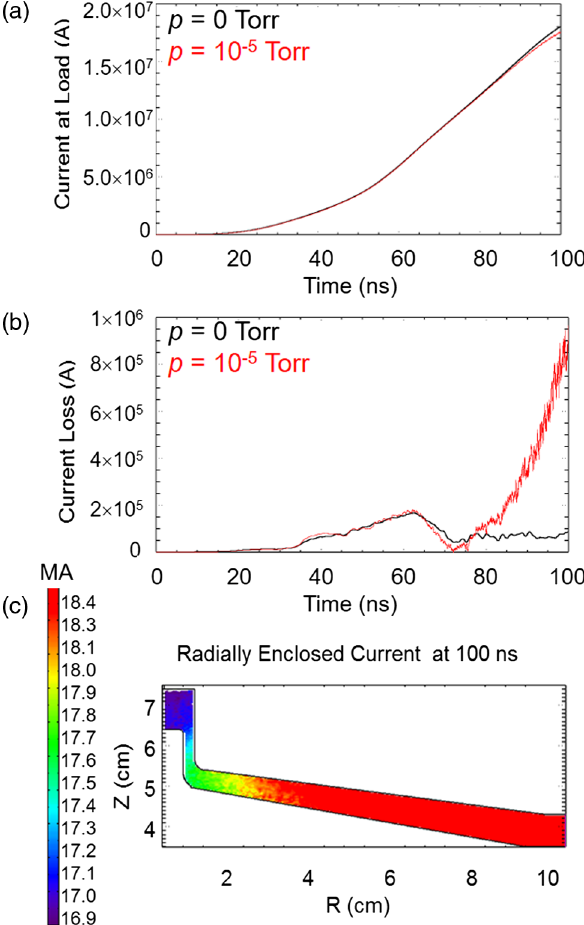
FIG. 9. For the two 18a inner MITL simulations, (a) the current delivered to the load ( z ¼ 6 cm), (b) the current loss before reaching the load, and (c) the current transported to a given position (radius- B θ product) in the MITL after 100 ns is plotted for the p ¼ 10 − 5 Torr simulation.